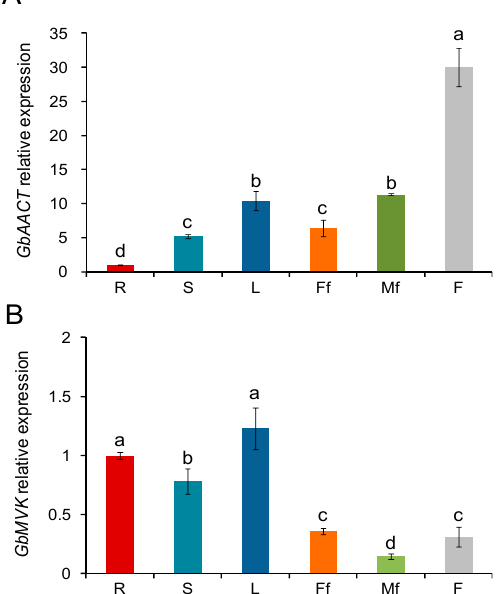
Figure 6. Gene expression Patterns of GbAACT ( A ) and GbMVK ( B ) in the various organs of G. biloba using qRT-PCR. The gene expression level of GbAACT and GbMVK in the root was set to 1, and those of GbAACT and GbMVK in other tissues were accordingly accounted and presented as the relative fold changes, respectively. R: root, S: stem, L: leaf, Ff: female flower, Mf: male flower, F: fruit. Data from qRT-PCR were shown as the mean ± SD (standard deviation) of three replicated assays. Means with different letters are significantly different at p < 0.05 by one-way ANOVA, with Tukey’s honestly significant difference test.